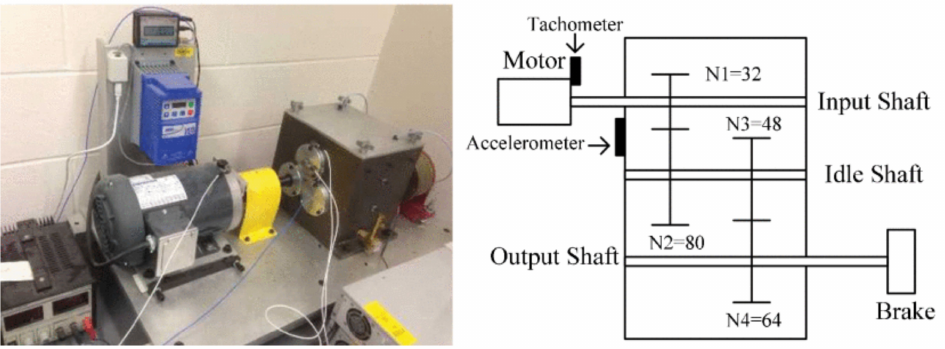
Figure 6. The benchmark two-stage